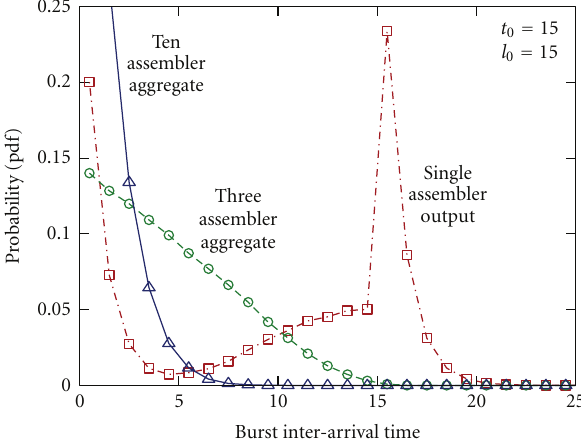
Figure 9: Hybrid burst assembly: burst inter-arrival time distribu-